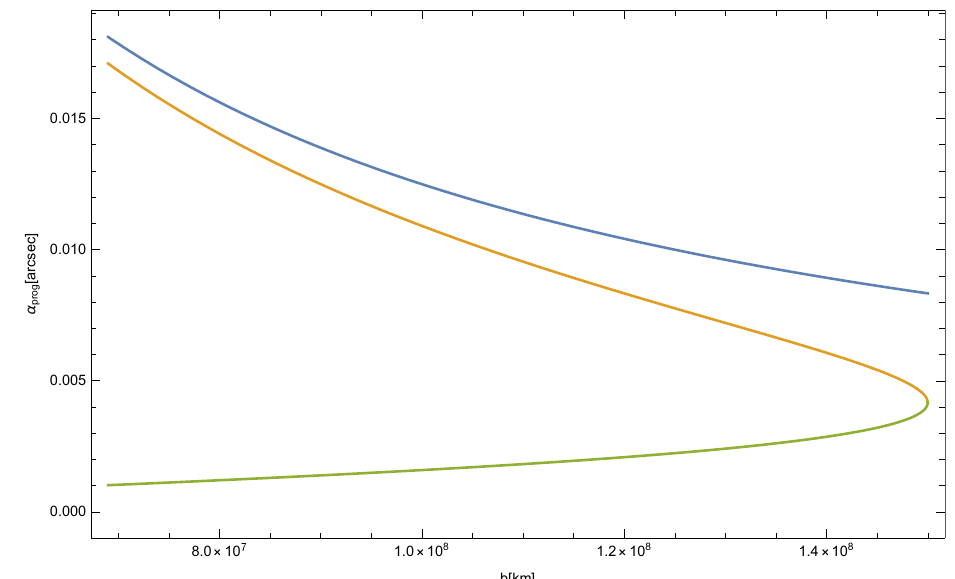
Figure 12. α in the prograde motion: The horizontal axis is the impact parameter for a photon orbit. The vertical axis means the deflection angle of light. The blue curve is the asymptotic deflection angle by a Kerr black hole. The orange curve means the deflection angle with finite-corrections by a Kerr black hole. The green curve shows the difference between the asymptotic bending angle and the deflection angle with finite-corrections by a Kerr black